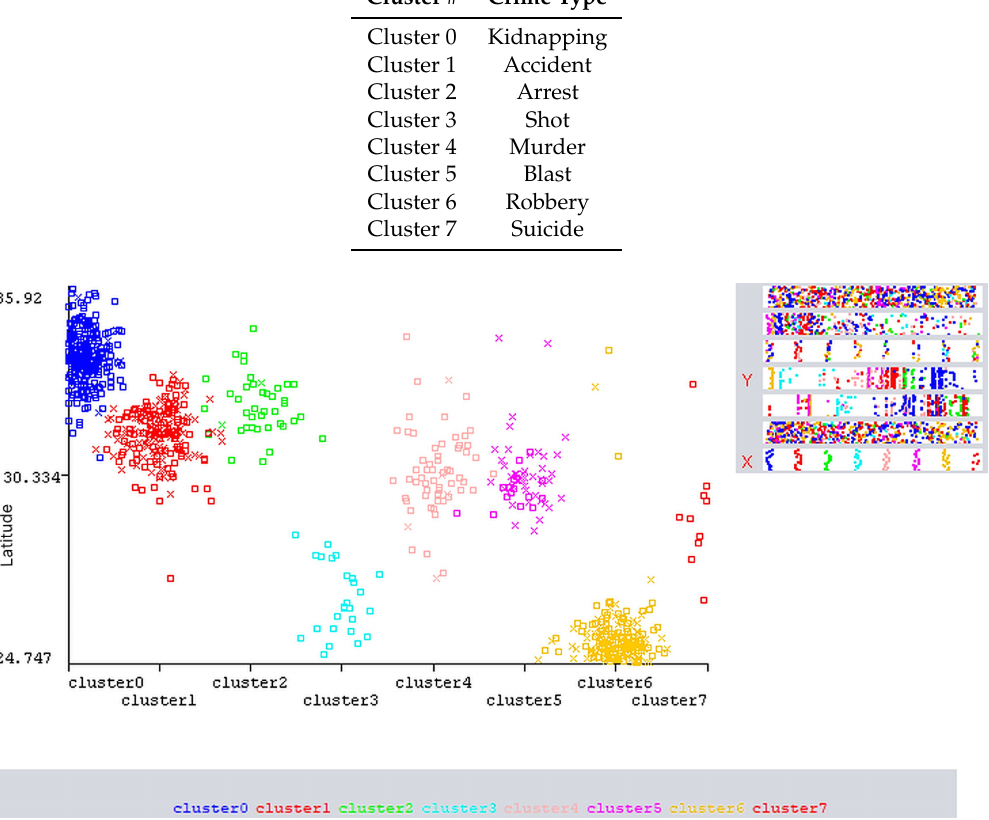
Figure 5. Clusters of crimes cases of Pakistan formed as a result of k-Means